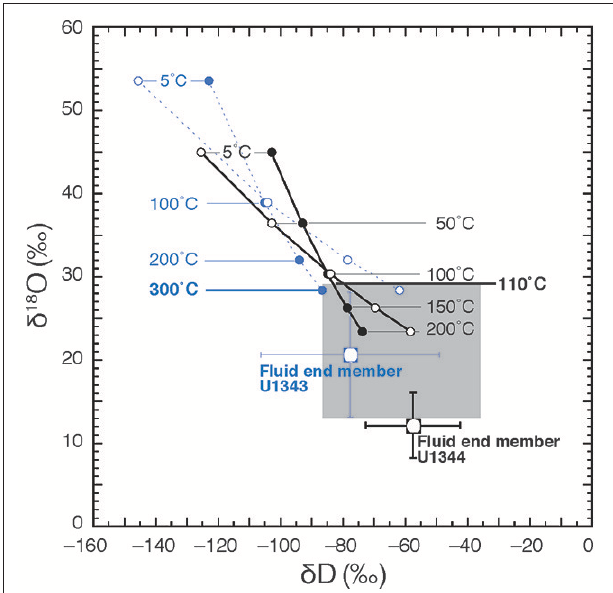
FIGURE 11 | Calculation of theoretical temperatures of fluid formation assuming equilibrium fractionation between pore fluid and clay minerals after Hensen et al. (2004). Theoretical δ 18 O values of clays are calculated after Sheppard and Gilg (1996) at different temperatures on the basis of fluid end members of Sites U1343 and U1344 and are plotted vs. D-values calculated after Yeh (1980) (filled circles) and Capuano (1992) (open circles). The blue circles and dashed lines show the calculation for Site U1343, and the black ones show the calculation for Site U1344. The shaded area is the range of 18 O vs. D-values previously reported for marine